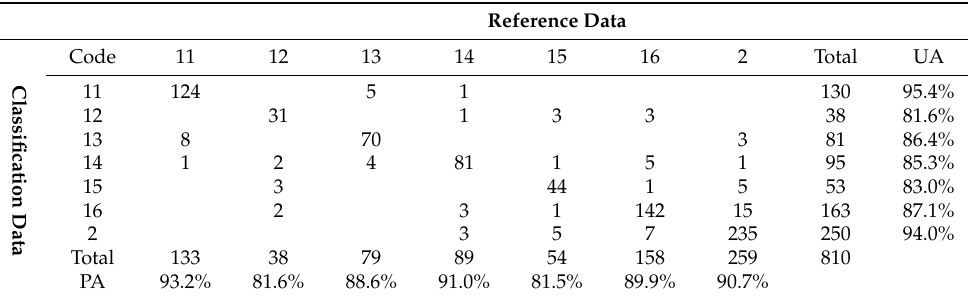
Table 2. Confusion matrix measuring the accuracy of the annual wetland classification result based on seasonal-rule-based wetland classification method. Note: The land cover types corresponding to the codes are shown in Table 1.